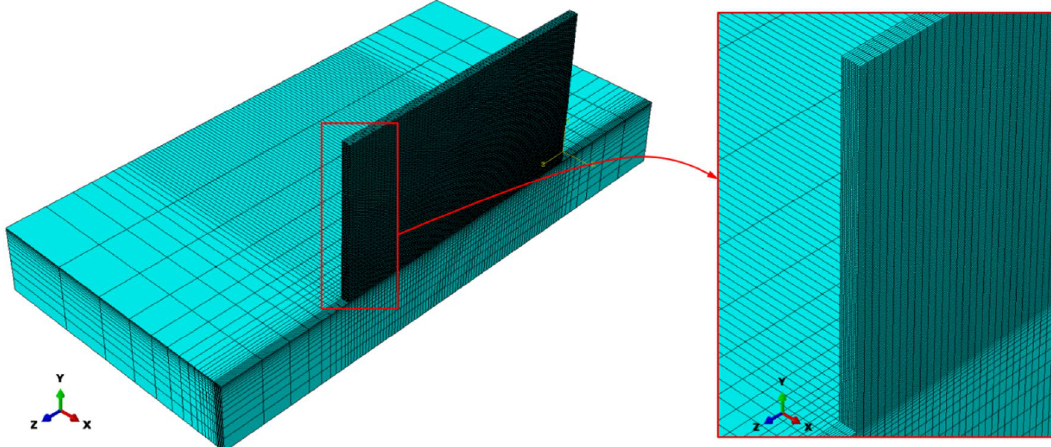
Figure 2. The mesh system used for the final model (14-layer structure).